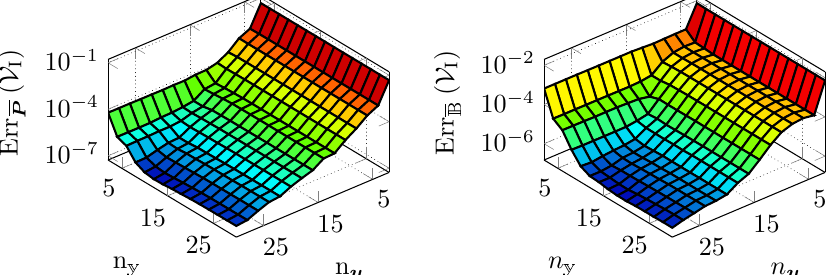
Figure 2. Sampling of the two-dimensional parameter domain [ 0,1 ] two sparse grids based on a one-dimensional Gauss–Legendre quadrature with different sampling densities.